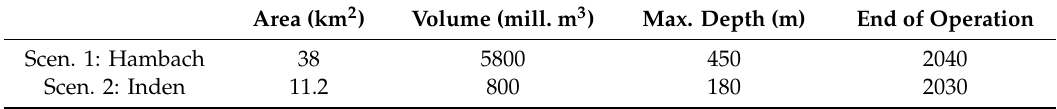
Table 1. Dimensions of future pit lakes in the German Rhineland